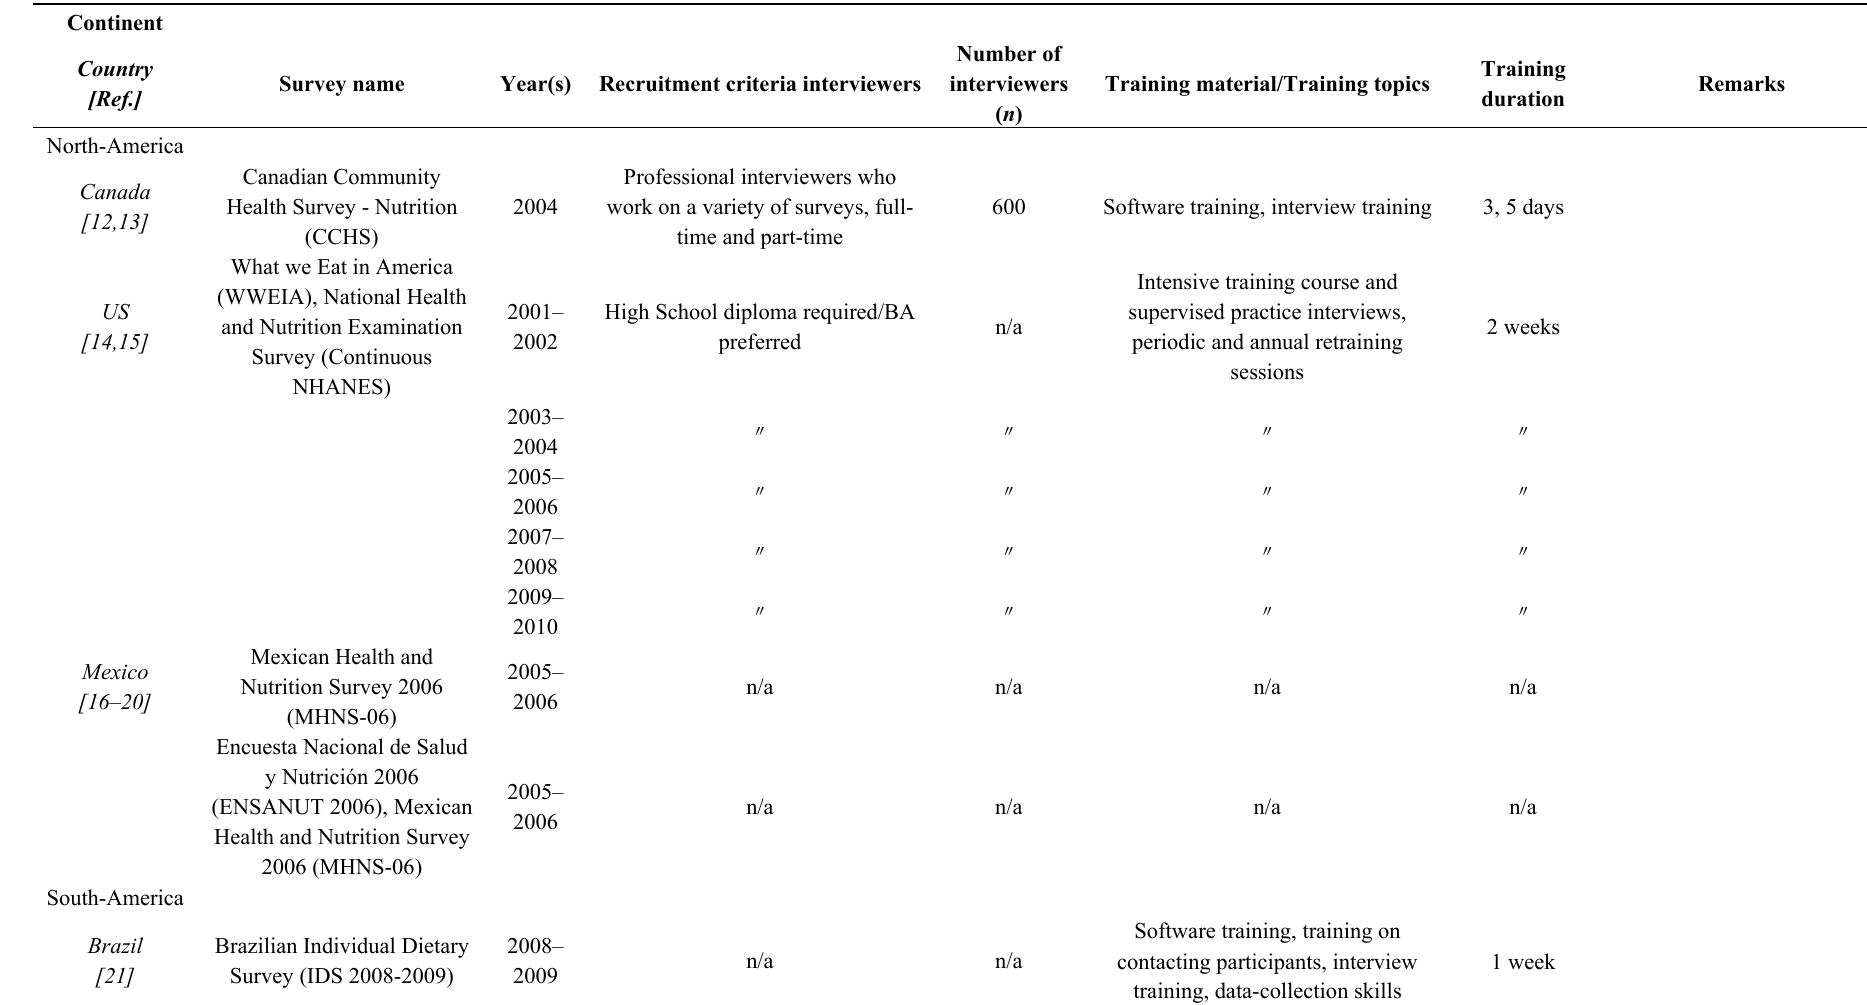
Table 7. Recruitment and training of the interviewers in national nutrition surveys per